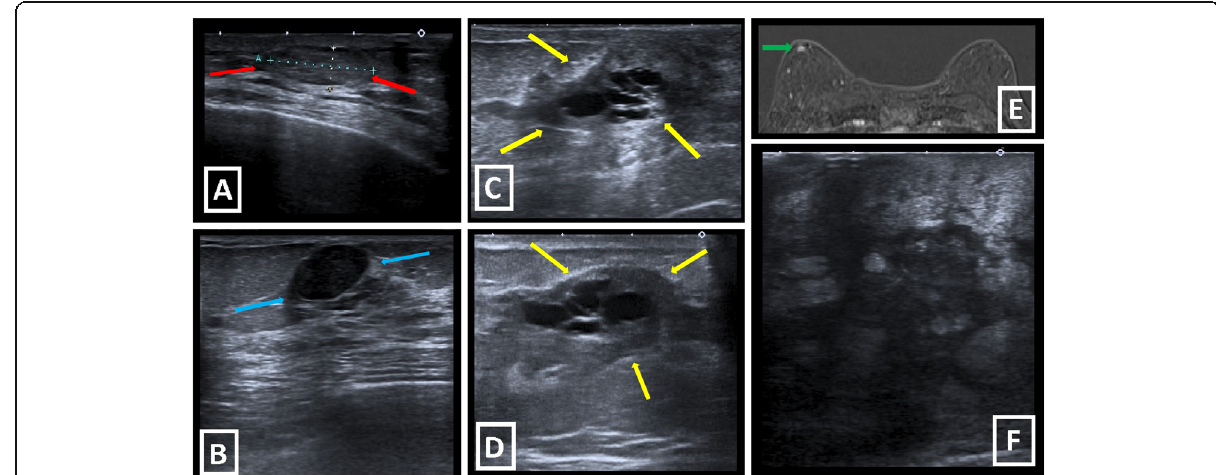
Fig. 2 Uncommon male breast lesions due to fibroepithelial or lobular origin. a Fibroadenoma is seen as well-defined, hypoechoic, solid lesion with posterior acoustic enhancement in US (red arrows). b Circumscribed, hypoechoic, solid lesion with slight posterior acoustic shadowing is diagnosed as “ Adenosis ” after biopsy (blue arrows). c , d Fibrocystic changes with apocrine metaplasia. US shows multiseptated cystic structures within retroareolar heterogeneous hypoechoic area in a 59-year-old male patient with palpable mass (yellow arrows). e After detecting right retroareolar ductal ectasia with peripheral hypoechoic heterogeneous area in US (not shown), subtraction image of dynamic MRI of 72-year-old male patient shows retroareolar well-defined enhancing focus which corresponds to the defined lesion. Biopsy reveals the diagnosis of “ Fibroadenomatoid changes ” . f Large, heterogeneous, ill-defined, hypoechoic mass with subcutaneous edema and pectoral muscle invasion (not shown) is diagnosed as